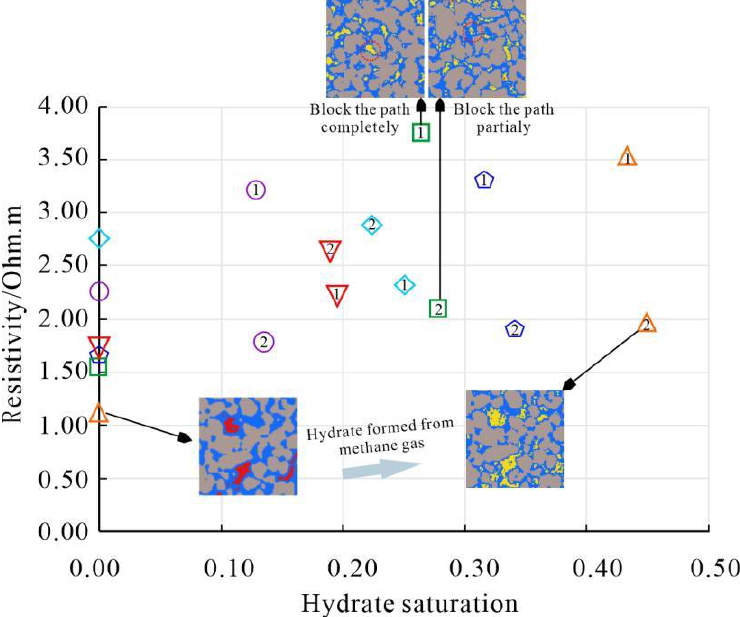
Figure 3. The resistivity of hydrate-bearing sediments under different hydrate saturations. Different symbol shapes represent, respectively, the six tests described in Table 1: triangles represent test 1, pentagons represent test 2, squares represent test 3, circles represent test 4, inverted triangles represent test 5, and rhombuses represent test 6. Numbers 1 and 2 located at the middle of symbols represent the upper and lower layers, respectively. Six representative data located at the left x -axis are from the initial state in which hydrate saturation is zero.